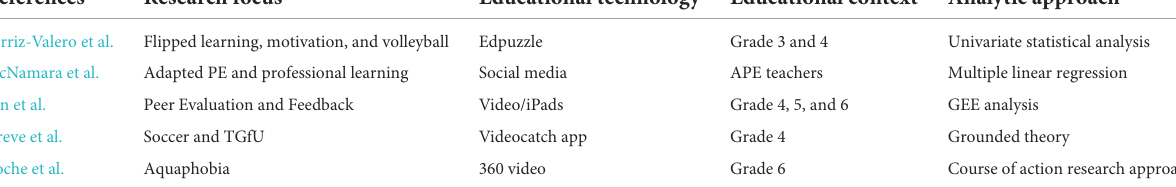
TABLE 1 Contributions to the Research